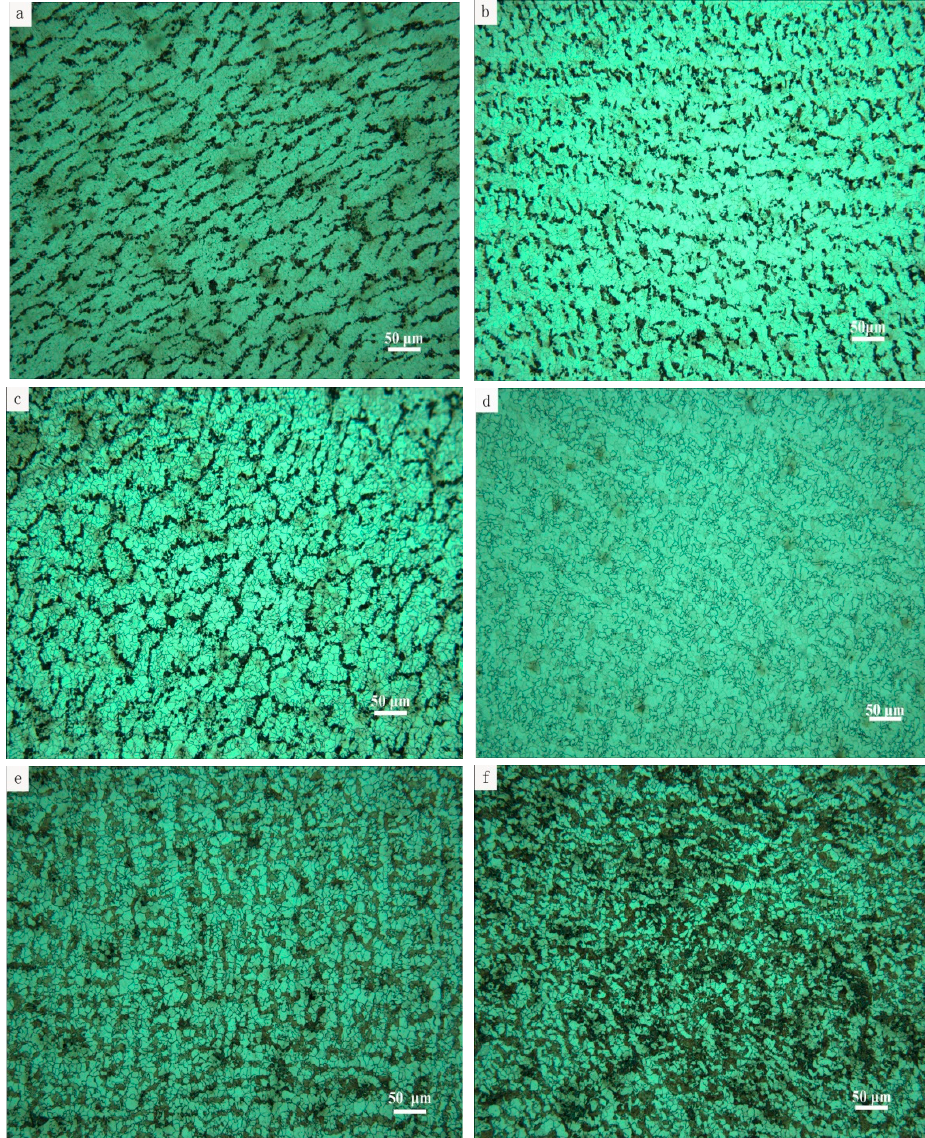
Figure 4. Microstructures of HRB600 grade steel samples with a holding time of 11 min at different temperatures ( a ): 600 °C, ( b ): 630 °C, ( c ): 650 °C, ( d ): 680 °C, ( e ): 700 °C, ( f ): 730 °C. temperatures ( a ): 600 ◦ C, ( b ): 630 ◦ C, ( c ): 650 ◦ C, ( d ): 680 ◦ C, ( e ): 700 ◦ C, ( f ): 730 ◦